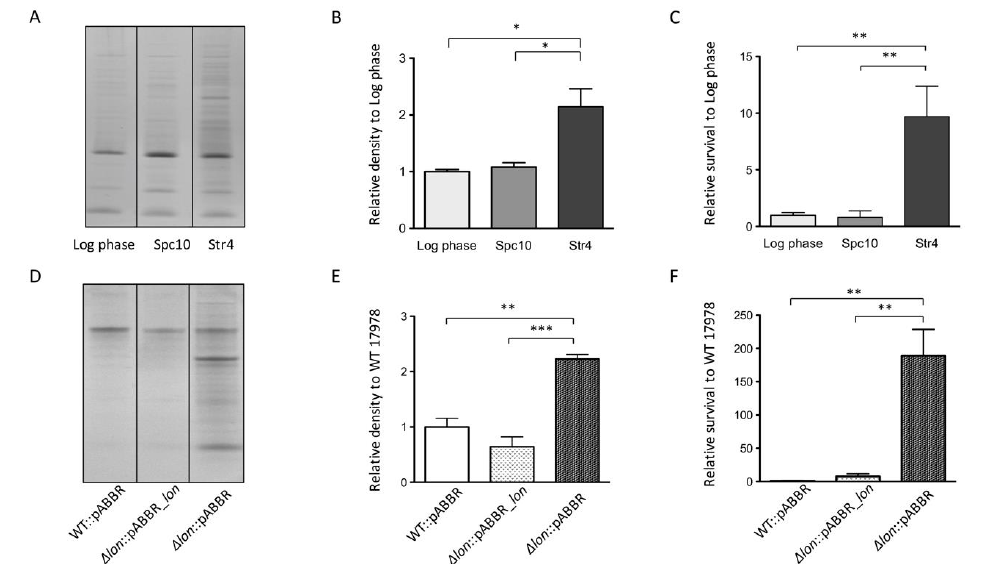
Figure 4. Inducing protein aggregate production is associated with increased desiccation tolerance.